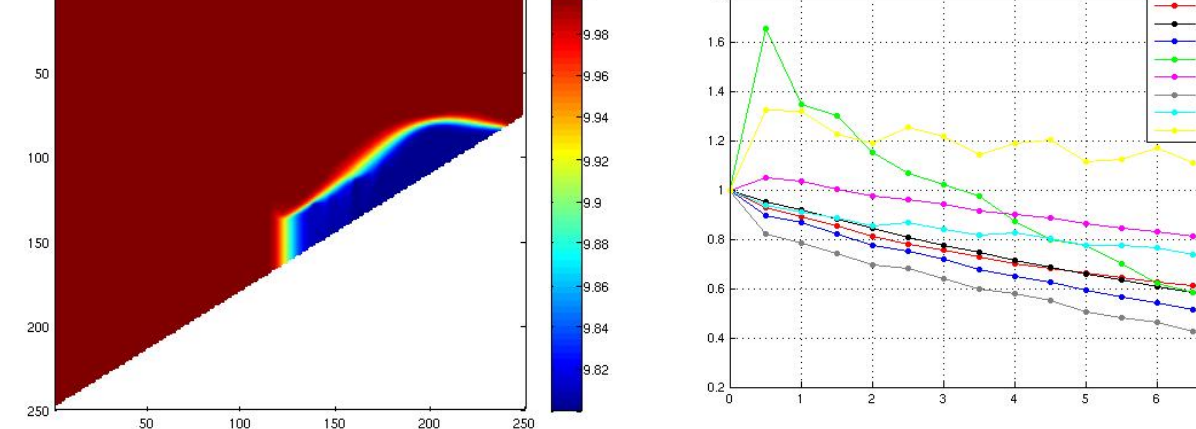
Fig. 4. Temperature structure (in C ◦ ) in the simulation with convec- tive adjustment (G09). Coordinates give grid levels.